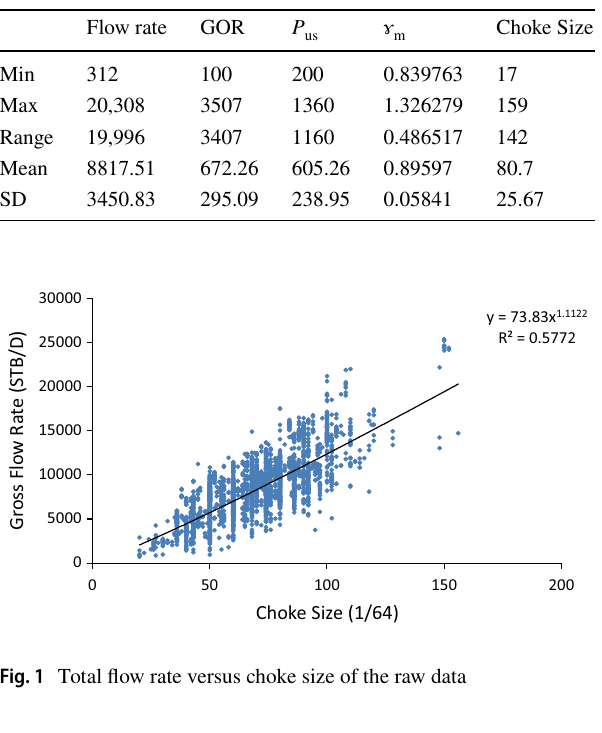
Fig. 2 Gas oil ratio versus choke size of the raw data